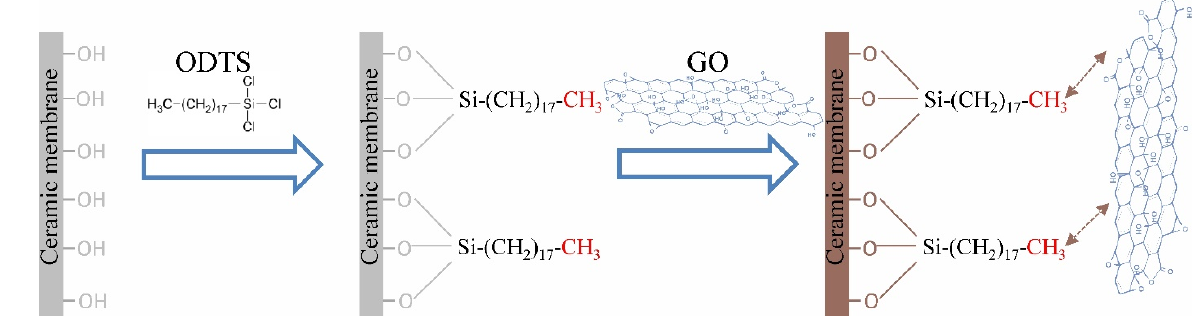
Figure 1. Ceramic membrane modification mechanism.